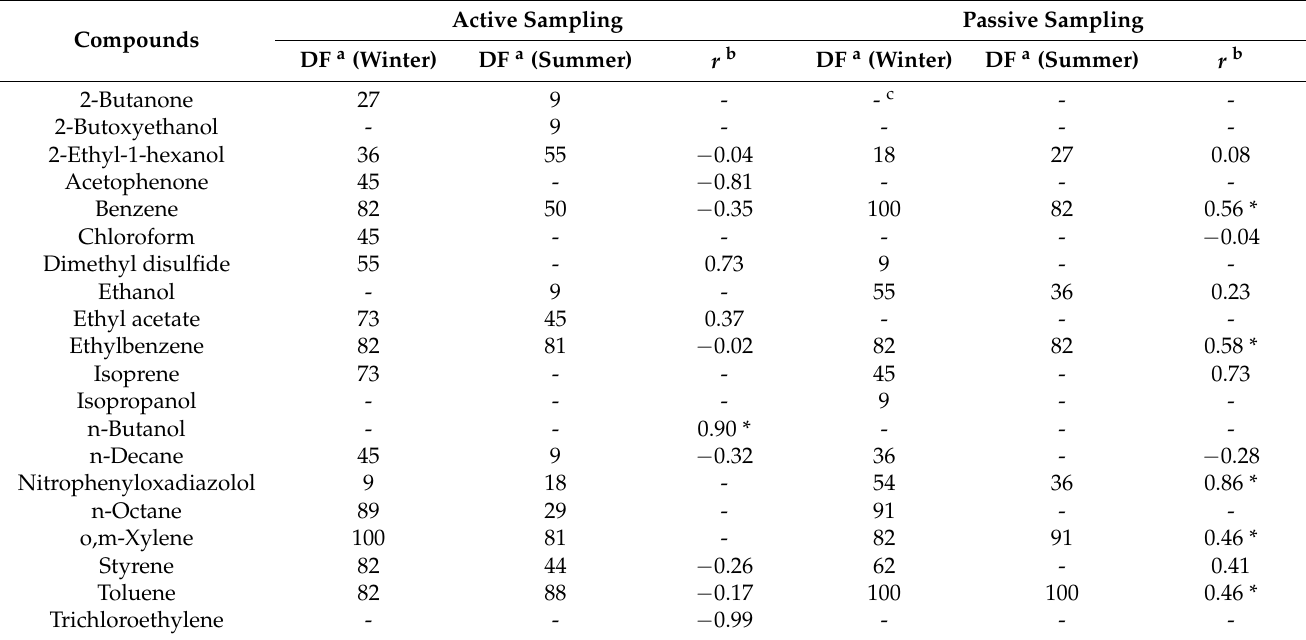
Table 2. Detection of mVOCs in 11 residential environments and correlation analysis between mVOCs air concentrations and airborne fungal